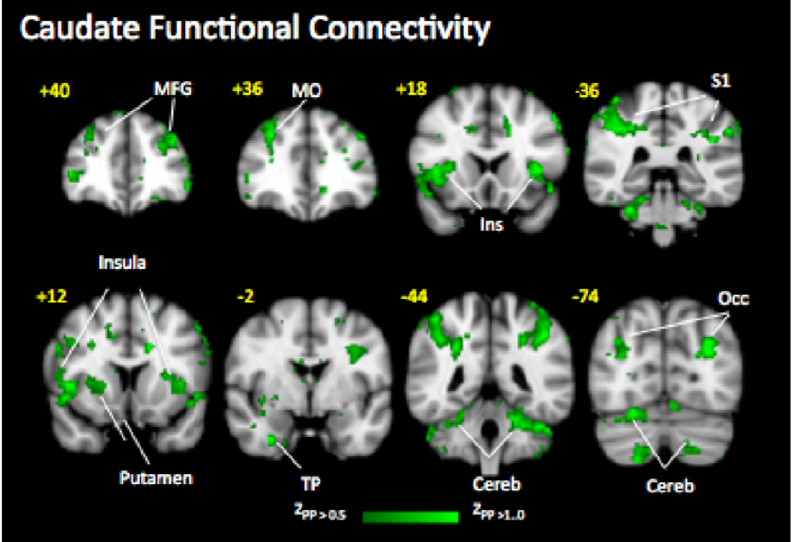
Figure 4. Functional Connectivity Maps. Caudate functional connectivity induced by Nalb-Sal that was blocked by naloxone (see Table 4). There was no functional significant connectivity induced by the Nalb-Nalox treatment.